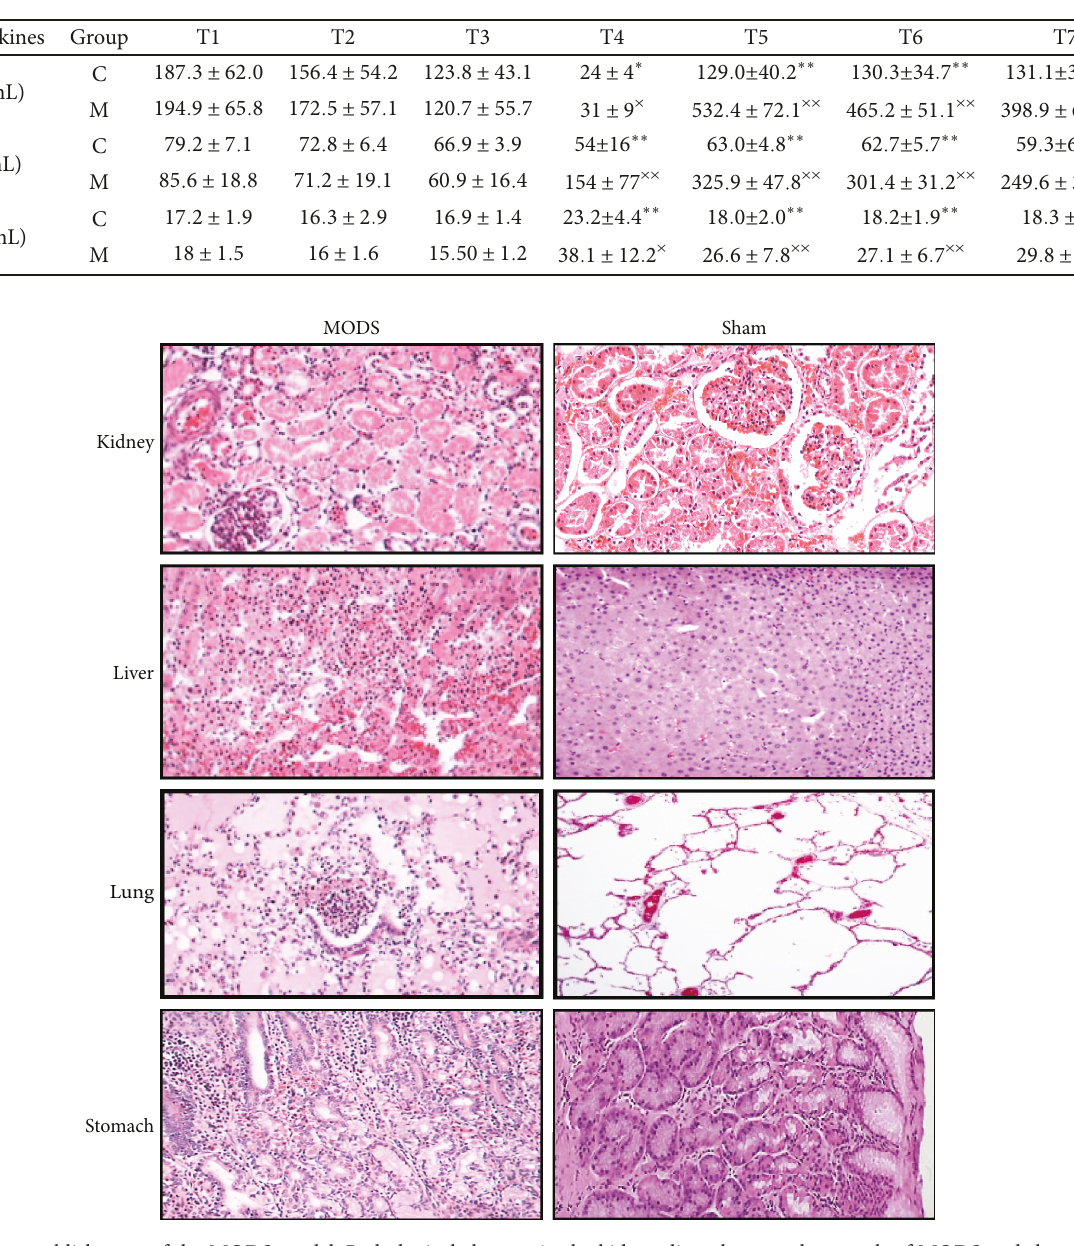
Figure 1: The establishment of the MODS model. Pathological changes in the kidney, liver, lung, and stomach of MODS and sham group pigs. Tissues were stained with HE and observed under a light microscope (magni fi cation, ×